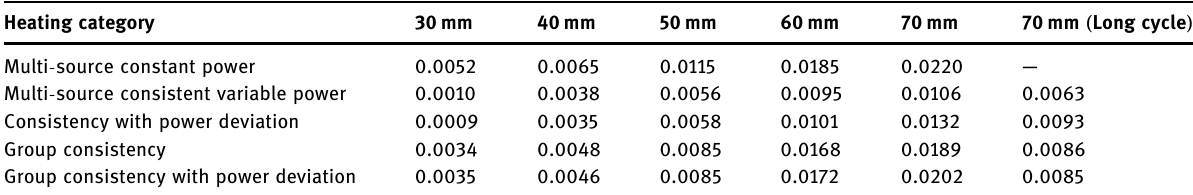
Table 9: Di ff erent heating models | S 11 | Heating category Multi - source constant power Multi - source consistent variable